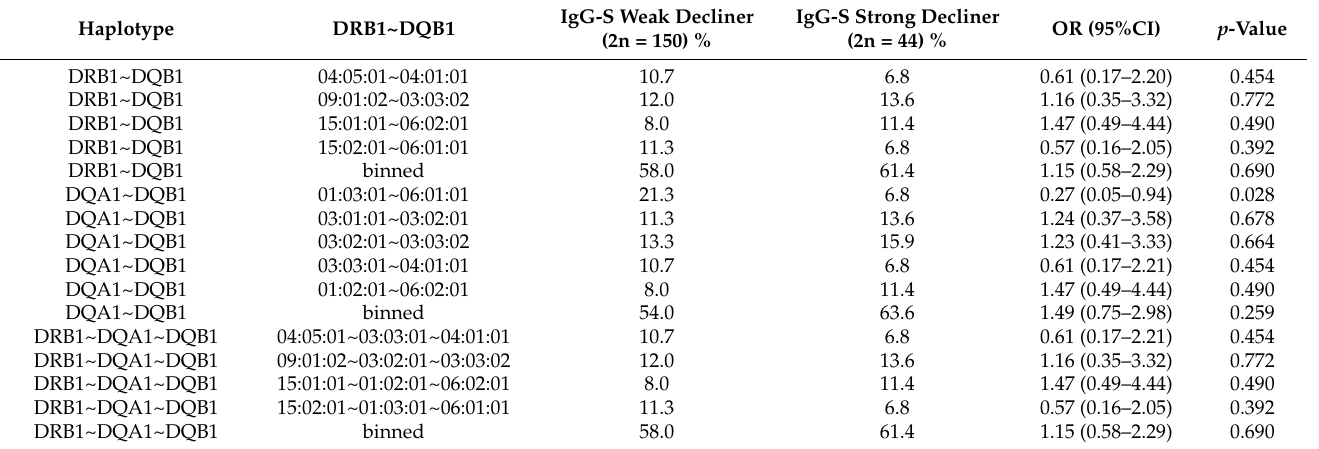
Table 5. HLA haplotype analysis for HLA-DRB1, -DQA1, and -DQB1 in 75 IgG-S weak decliners and 22 IgG-S strong decliners. Abbreviations: OR, odds ratio; 95%CI, 95% confidence interval; binned, rare HLA alleles with expected count <5 are combined into a common